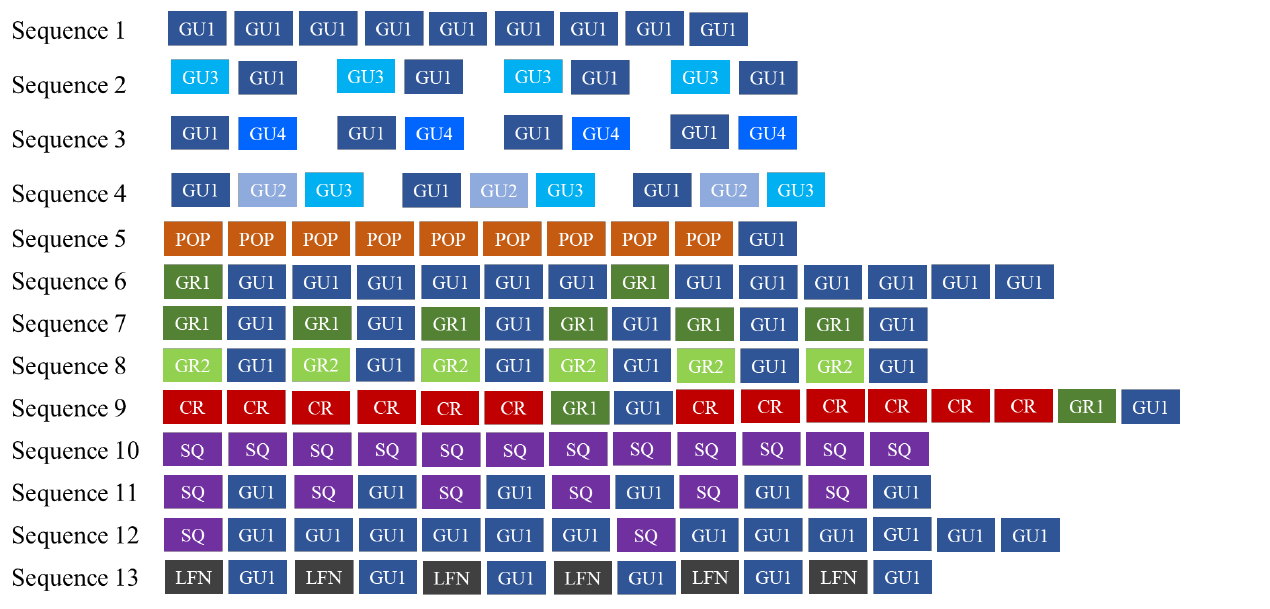
Figure 6. Bray-call sequences identified in this study met five distinct paradigms suggested by [1] for information encoding (repetition, diversity, combination, ordering, and timing).